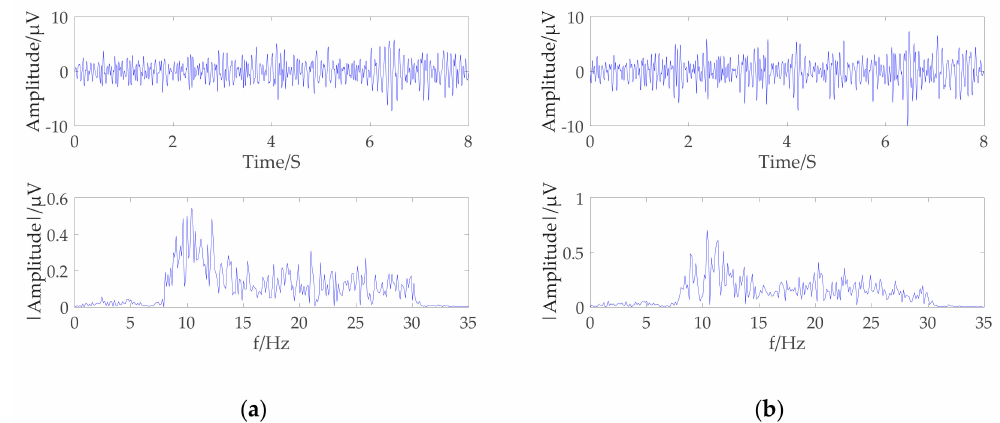
Figure 5. Electroencephalogram (EEG) signal and spectrum of left-hand motor imagination: ( a ) Description of C3 channel EEG signal and spectrum; ( b ) Description of C4 channel EEG signal and